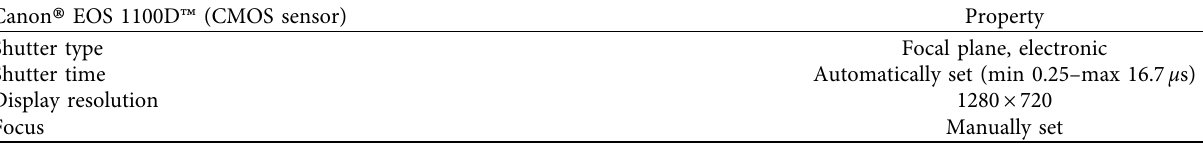
Table 5: Details of the reflex camera.